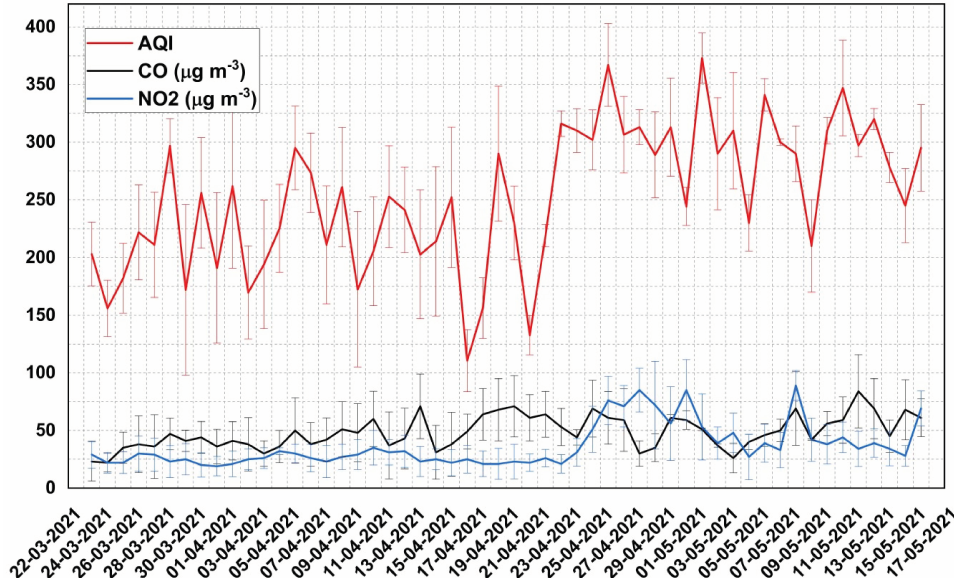
Figure 2. Daily variation in space–time-averaged values of air pollution. The variation in AQI, CO and NO 2 during the peak of the second wave of the pandemic observed over Delhi on a daily